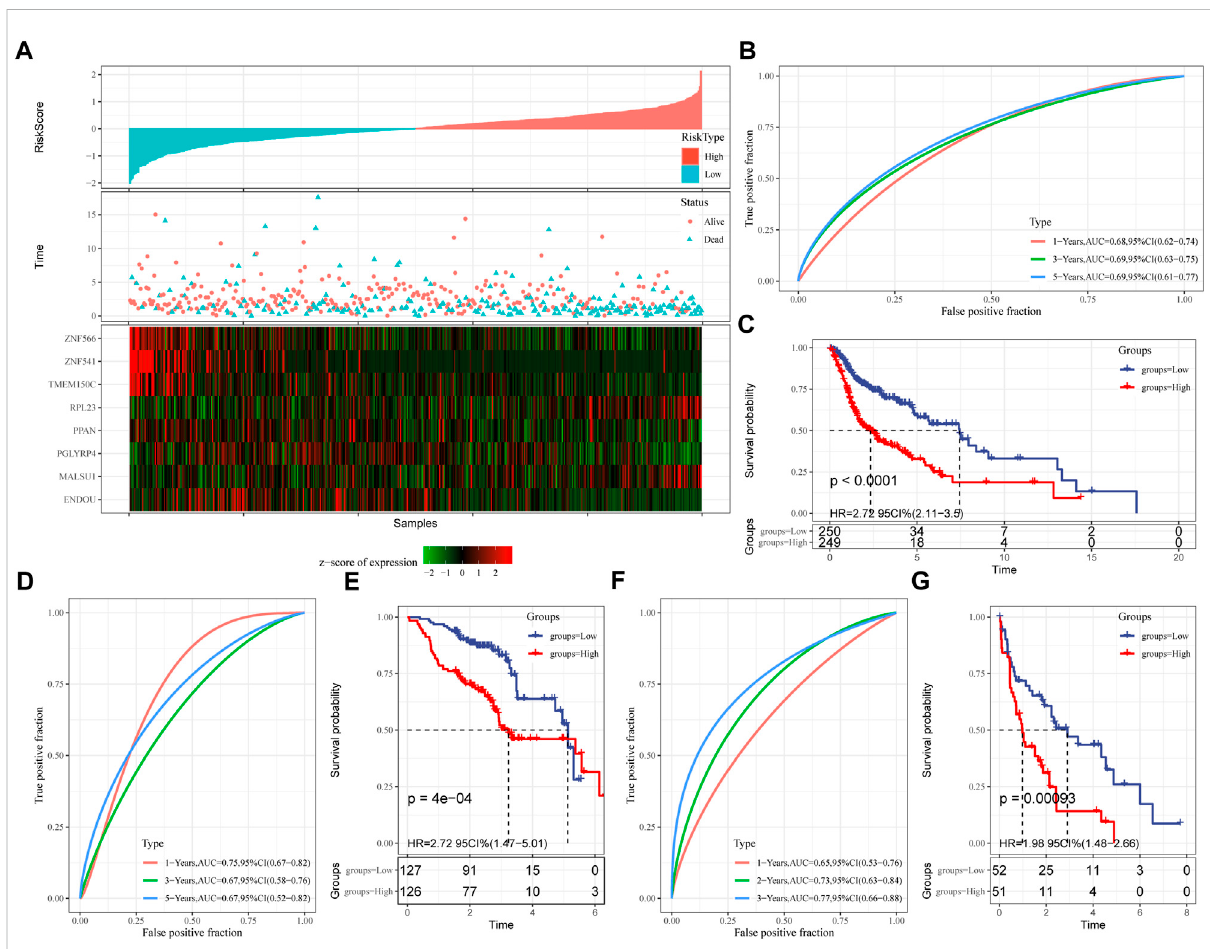
FIGURE 6 Establishment and validation of clinical prognostic model. (A) FPRS in TCGA-HNSC data set, survival time and survival status and expression of ferroptosis-related prognostic genes; (B) ROC curve and AUC of FPRS classi fi cation in TCGA-HNSC data set; (C) FPRS in TCGA- KM survival curve distribution in HNSC dataset; (D,E) ROC curve and KM survival curve of FPRS in GSE65858 cohort; (F,G) ROC curve and KM survival curve of FPRS in GSE 42743